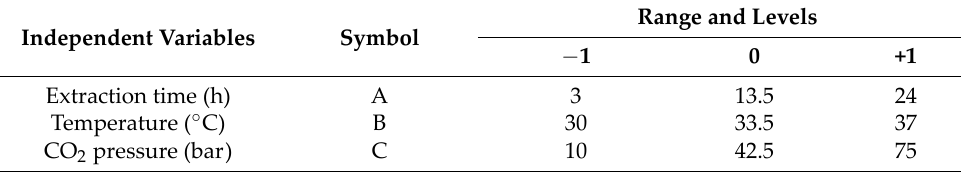
Table 6. Experimental design range and values of independent variables.